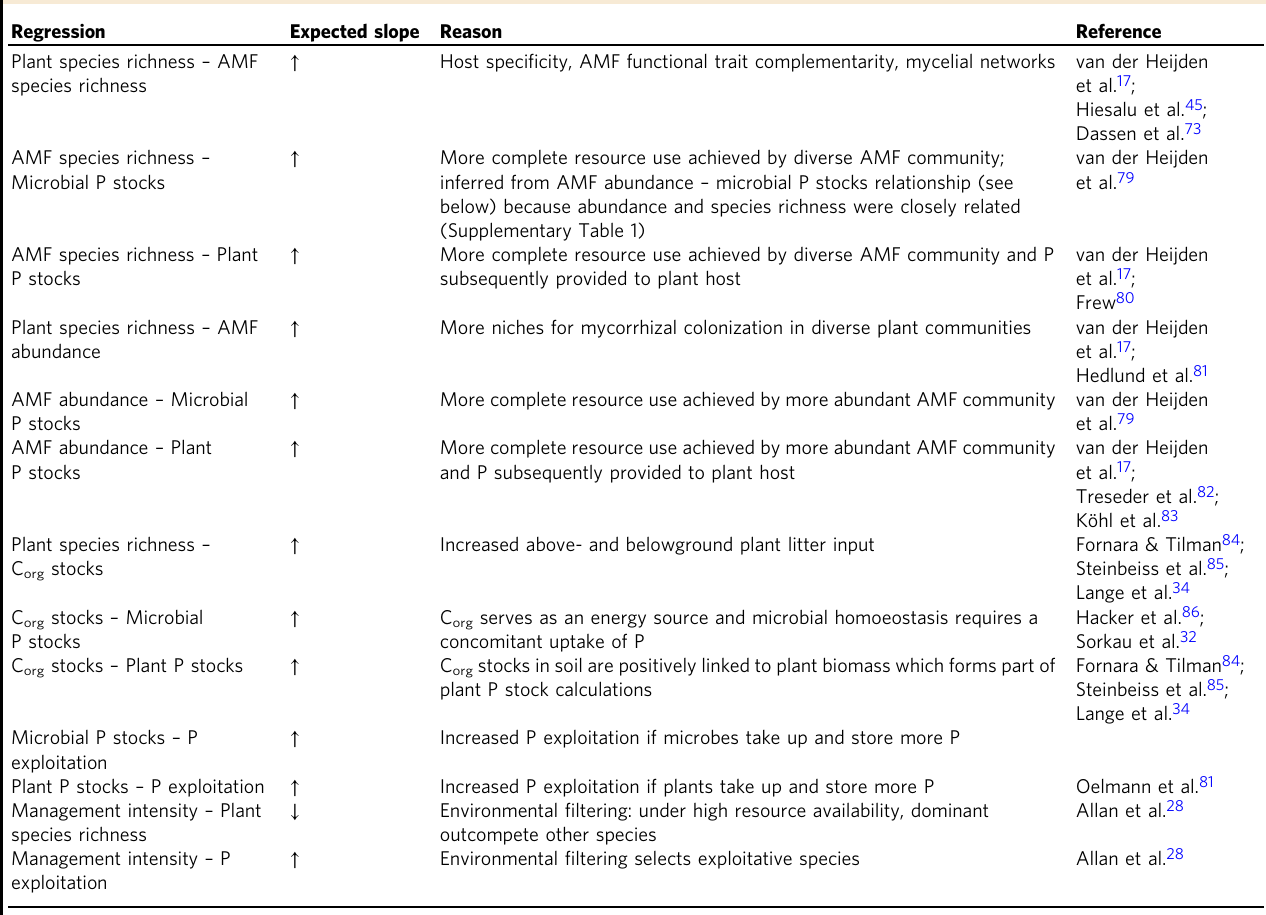
Table 1 Expected relationships underlying the structural equation models of the biodiversity experiment and the agricultural